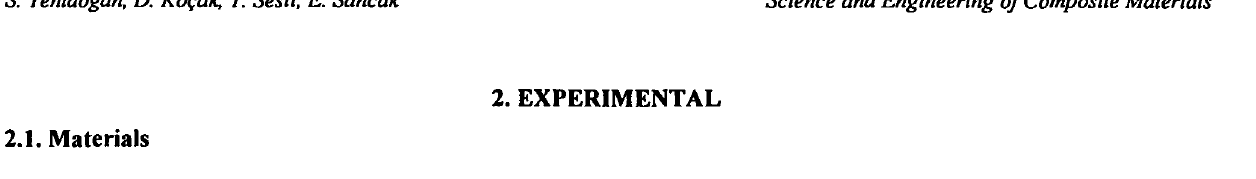
Properties of Ε-glass fiber used in biaxial warp knitted fabrics